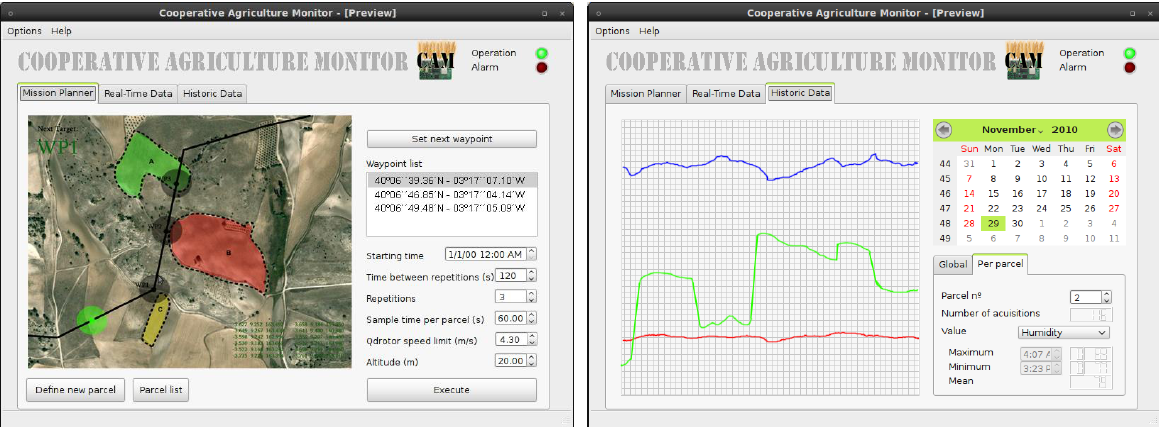
Figure 11. GUI employed in the base-station to aid the crop managers to carry out the frost monitoring